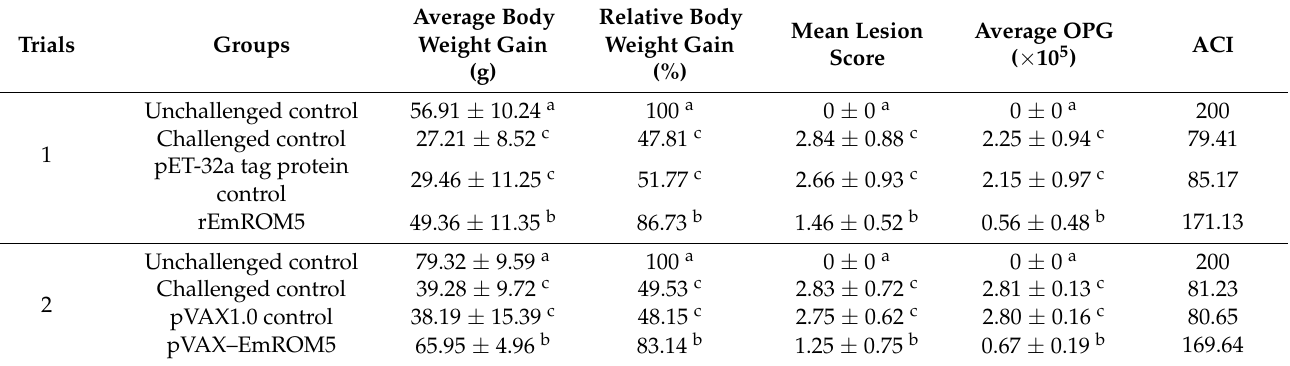
Table 3. Protective efficacy of rEmROM5 and pVAX-EmROM5 against challenge with E. maxima ( n = 30, value = mean ±